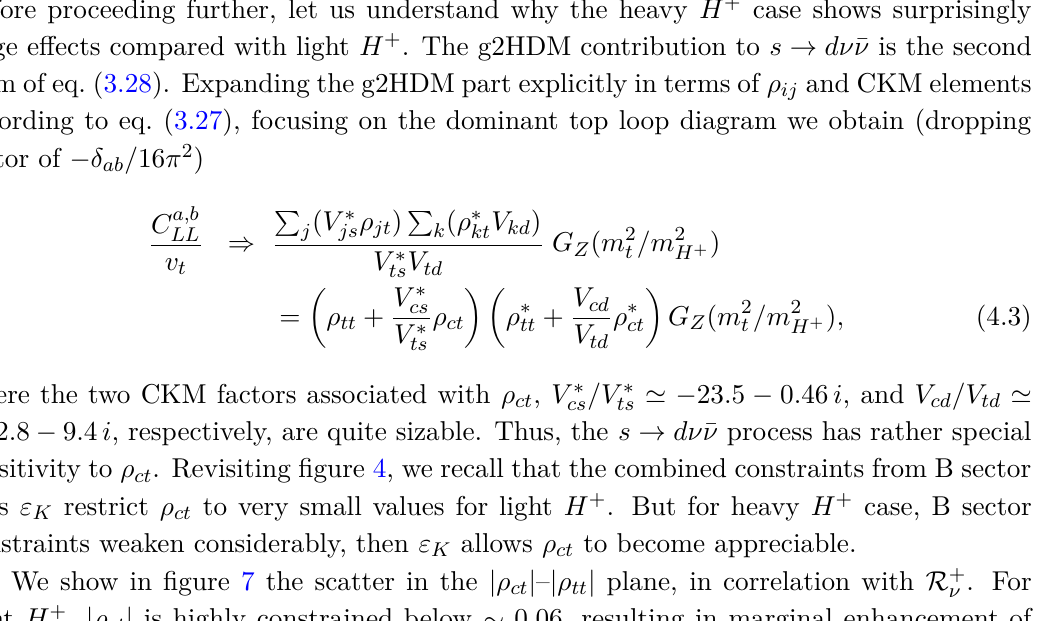
(upper) and R 0 (lower) as function of κ , and correlation with NP in ε 0 /ε ν ν